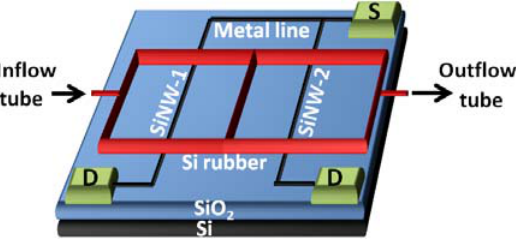
Figure 10. Schematic drawing of silicone nanowire (SiNW) chip dually functionalized with antibodies against tumor necrosis factor-alpha and interleukin-6, respectively at SiNW-1 and SiNW-2 [93]. S denotes source and D denotes drain. Adapted with the permission of